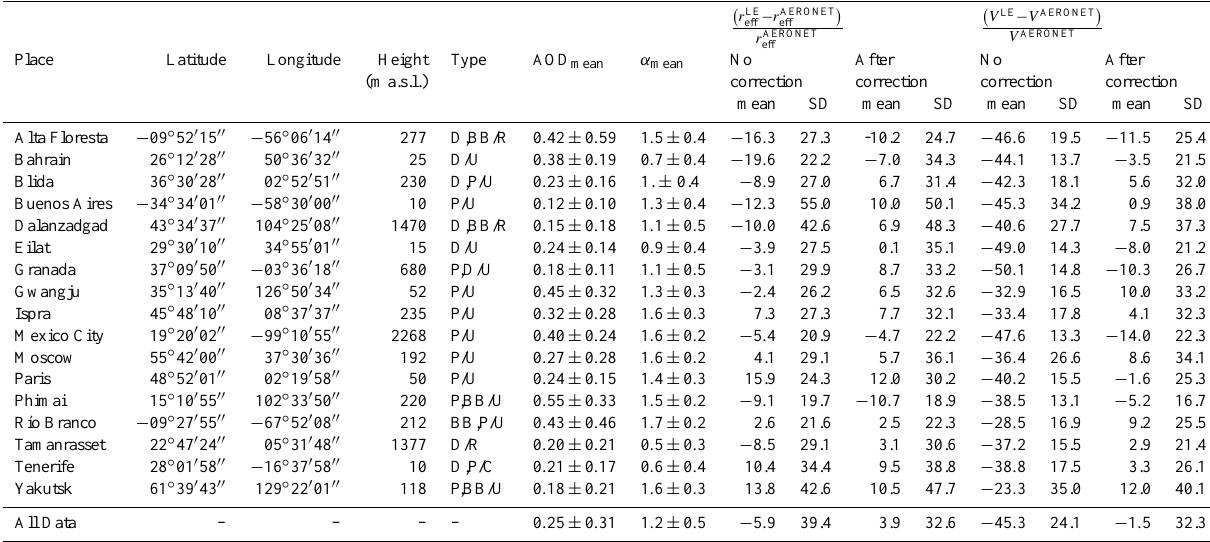
Table 2. AERONET sites used to evaluate the correction functions of Table 1. The stations are defined according to their aerosol types such as desert (D), biomass-burning (BB) or anthropogenic pollution (P). Also it is include if they are remote (R), urban (U) or coastal (C). The mean aerosol optical at 440nm (AOD mean ) and Ångström parameter between 440–870nm ( α mean ) are included. Also, the mean and standard deviations of the differences between linear estimation and the operational AERONET code, before and after applying corrections, are included both for effective radius ( r eff ) and columnar volume aerosol content ( V ).